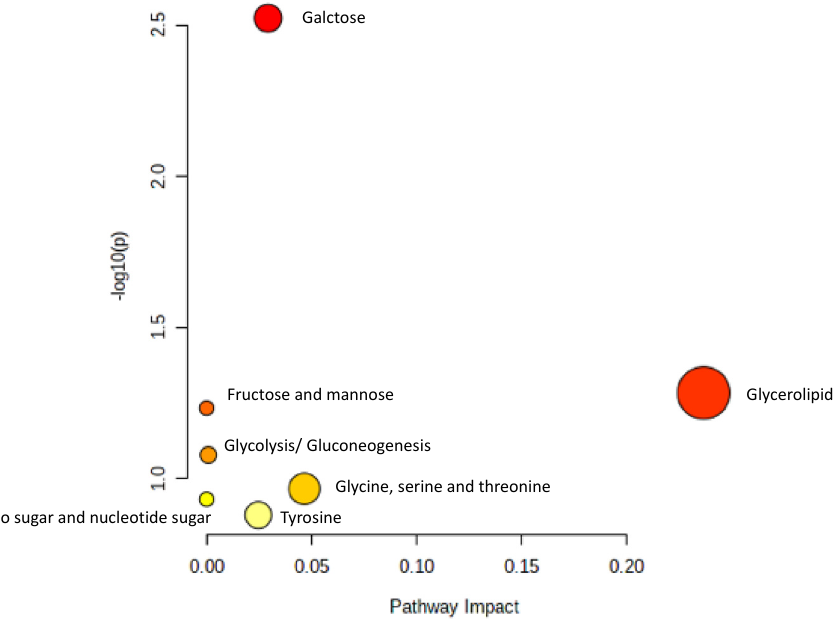
Figure 7. Summary of pathway analysis.